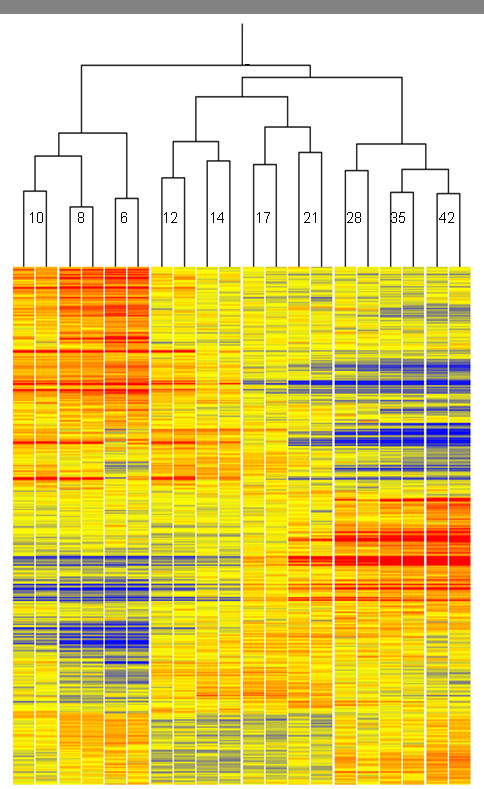
Hierarchical clustering of samples by gene expression. Gene set is same as that in Figure 1. Co-expression measure was Pearson correlation. All replicates cluster as pairs, for which the stage is shown as days after anthesis.